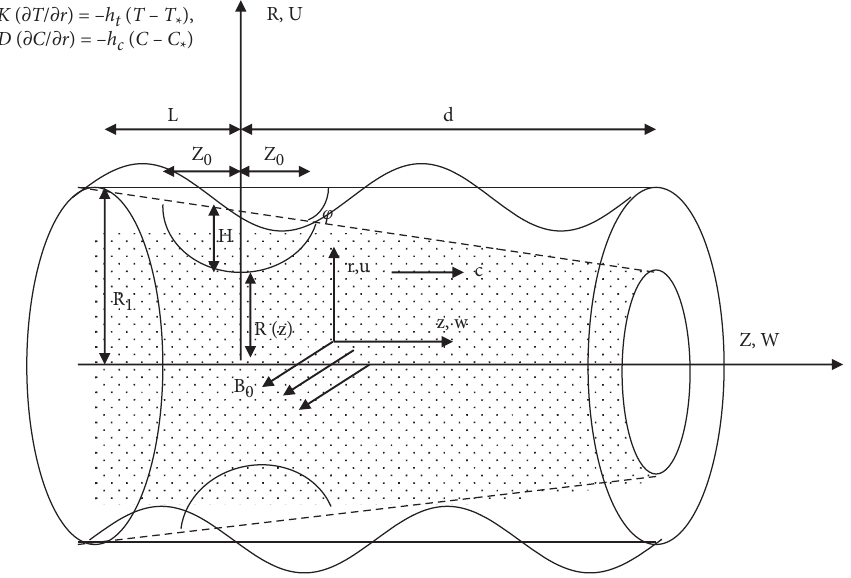
Figure 1: Sketch of the physical situation of the